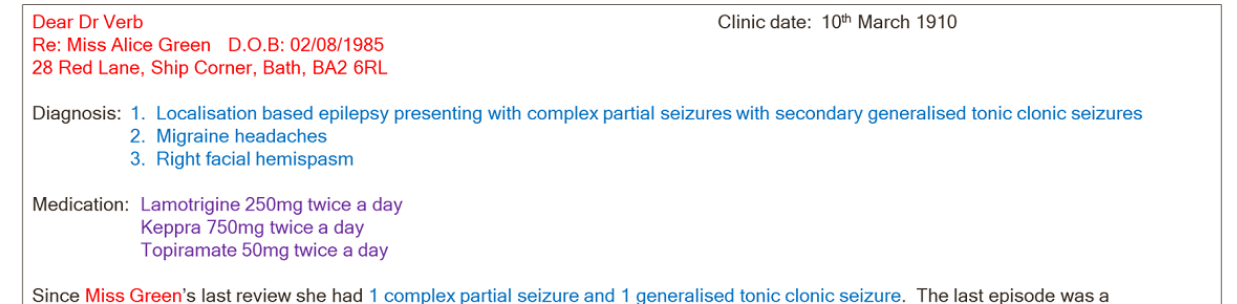
Figure 1. Synthetic clinic